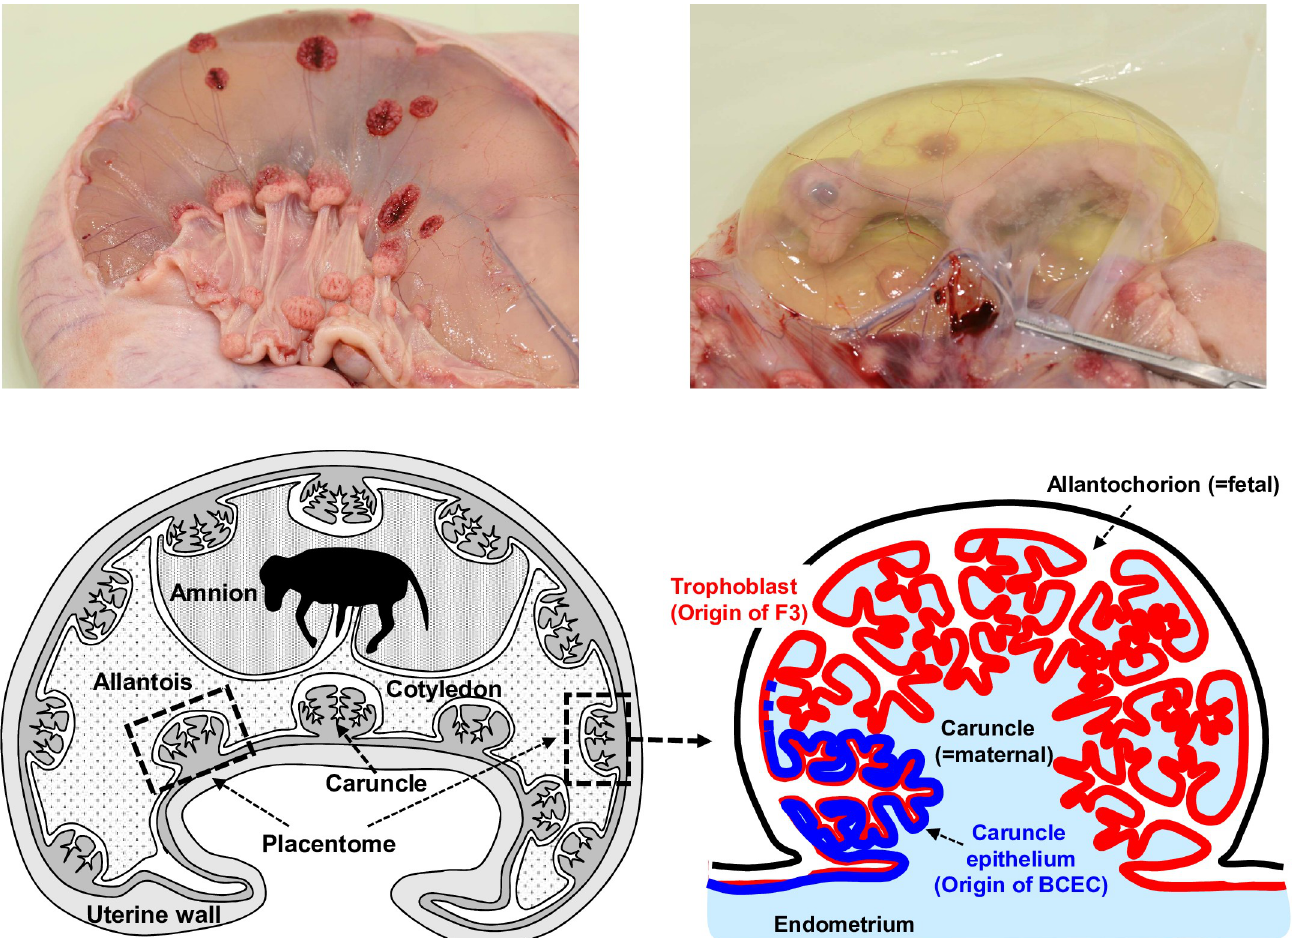
Fig 2. Extracted bovine uteruses and schematic anatomy of bovine placenta. The photographs in the upper part show uteruses extracted from the heifers during necropsy. The dark red structures visible on the surface of the organs shown on the upper left photograph represent the cotyledons as indicated by an arrow. Another arrow points at a caruncle. The anatomy of the bovine placenta is illustrated in the schemes below. The drawing on the left shows the uterus with the fetus whereas the scheme on the right represents a magnified image of the placentome (marked by a box in the left scheme) illustrating its location and how the structures are in contact represented by the fetal (red) and maternal (blue) epithelium, from which the cell lines used in our analyses were derived (F3 and BCEC,